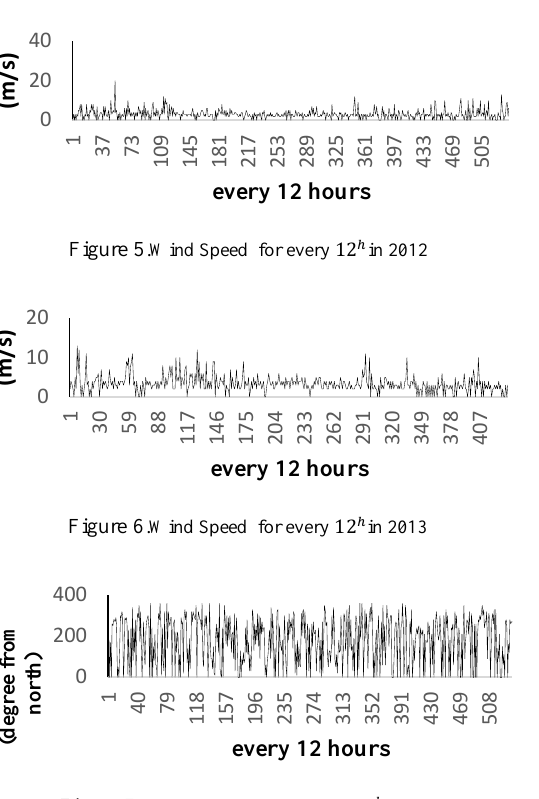
Figure 7 .Wind Direction for every 12 ℎ in 2012